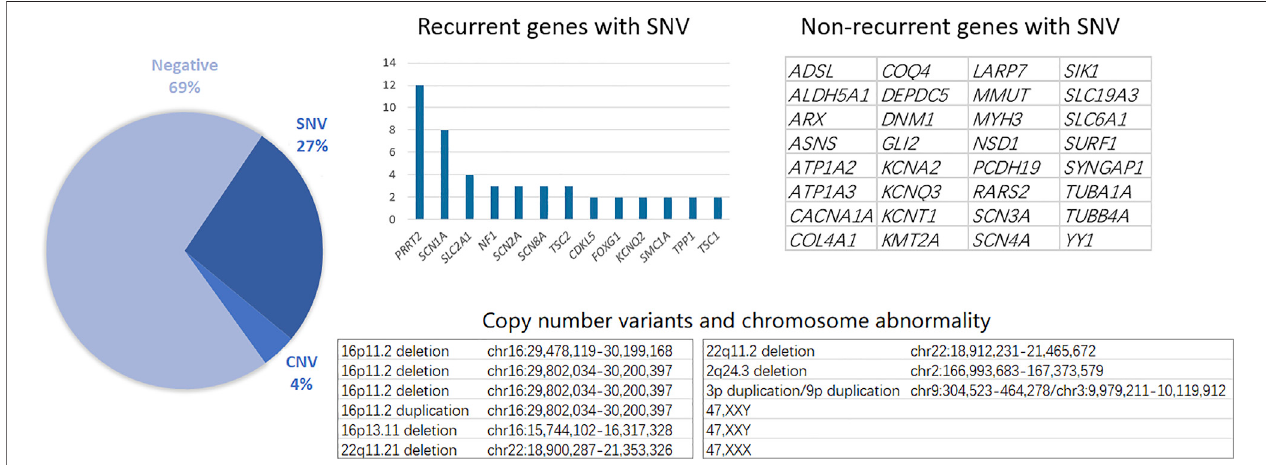
FIGURE 1 | Genetic diagnosis spectrum and pathogenic SNV and CNV in the childhood epilepsy cohort.